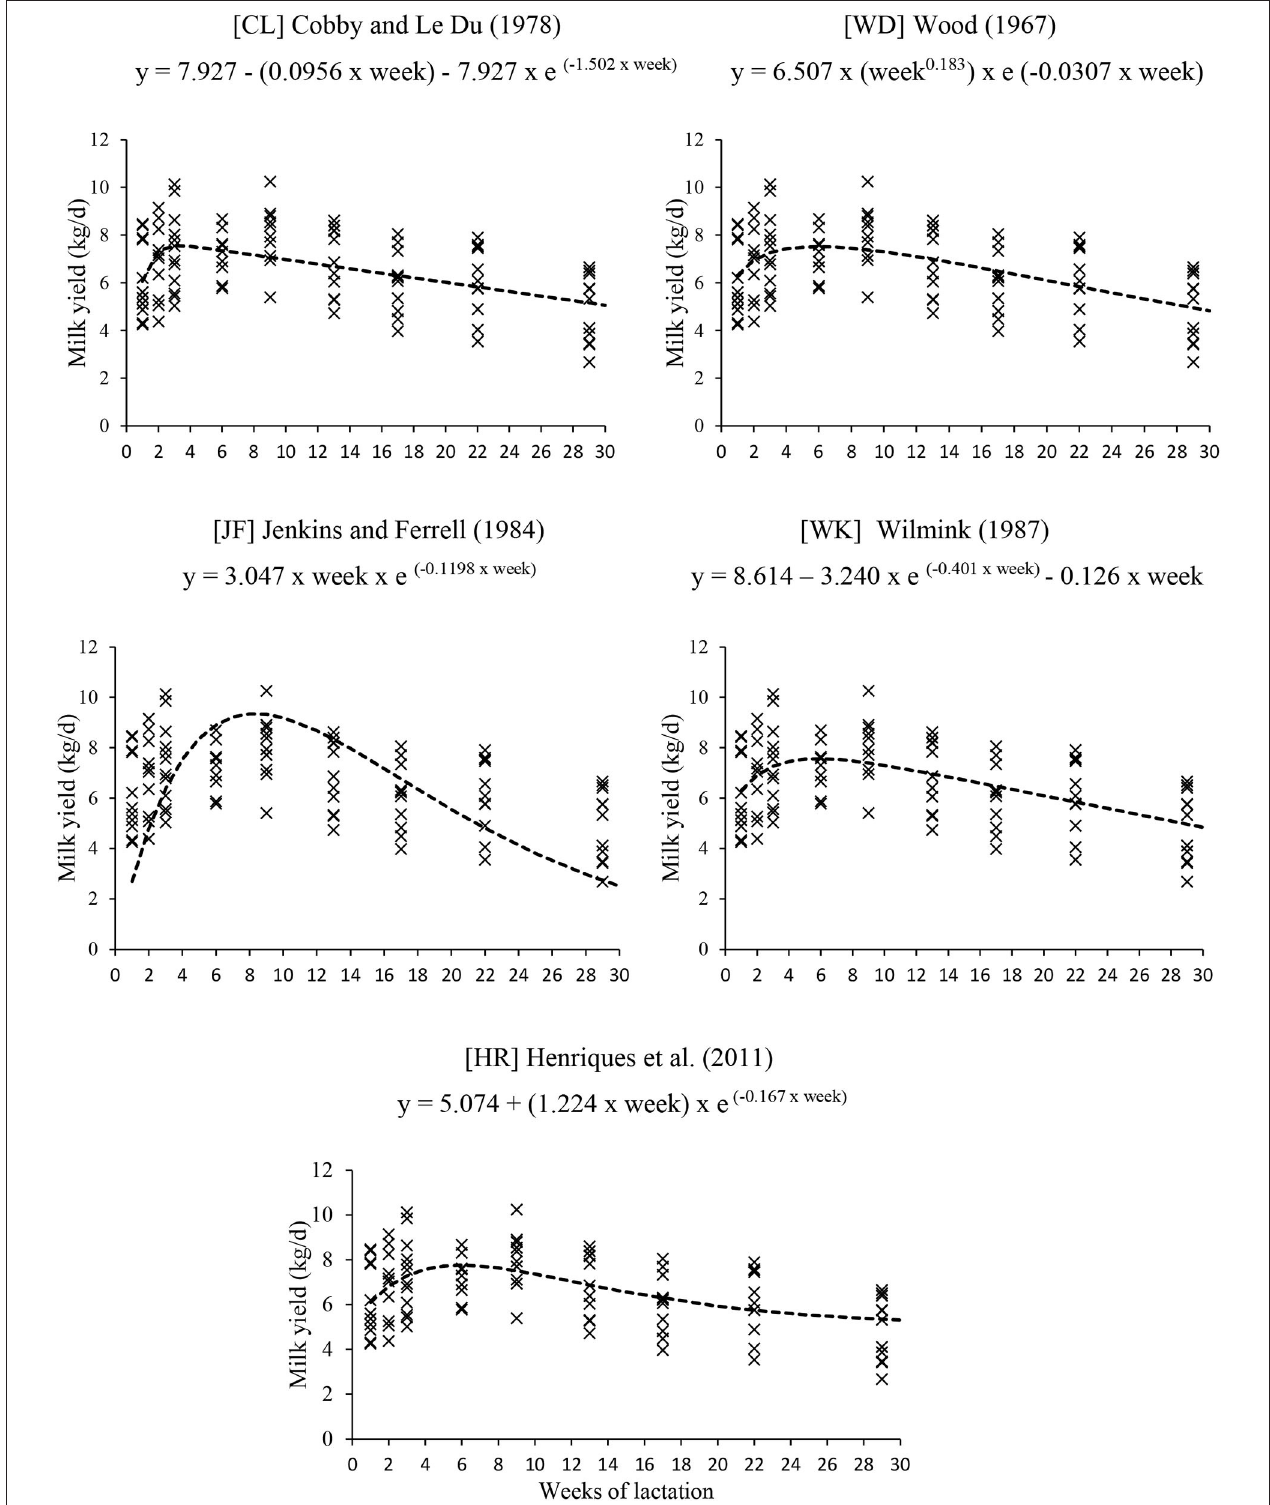
FIGURE 4 | Equations to predict milk yield of multiparous cows under grazing.